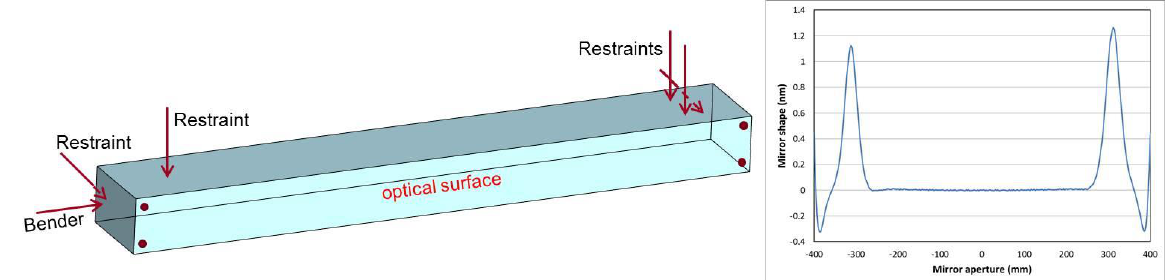
Figure 2. A possible way to specify shape errors on a mirror, when dealing with preservation of the wavefront. Since the source is diffraction limited, and the SR is dependent on wavelength, it is better to not over-specify the mirror, but require only the figure errors needed for a given length.